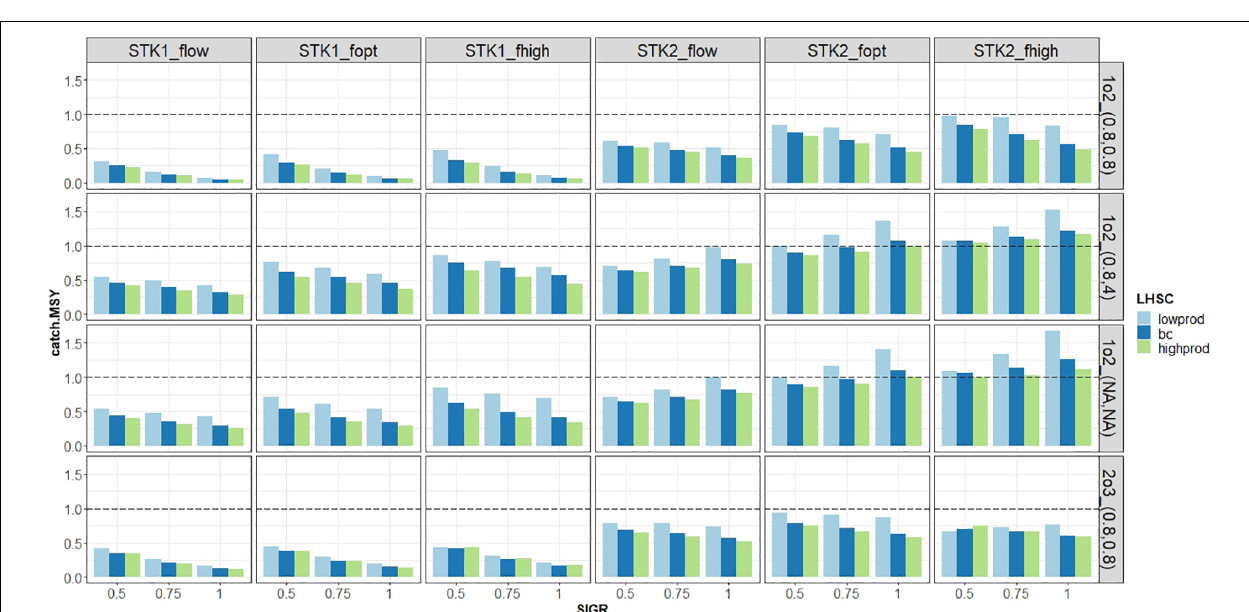
FIGURE 12 | Biological risks (Risk3.Blim: maximum probability of falling below B lim ) in the long-term (last 10 projection years) versus the standard deviation of recruitment (x-axis) and stock productivity (colours) under an in-year advice. The columns correspond to the alternative OMs (as combination of the stock-type and historical exploitation) and the rows to the configurations of the rule (harvest control rule type and uncertainty cap lower and upper limits). Dashed line corresponds to the 0.05 risk. See Table 1 for definitions of abbreviations. Interactive version of the figure is available online at https://aztigps.shinyapps.io/Sanchezetal2021_FMS/.